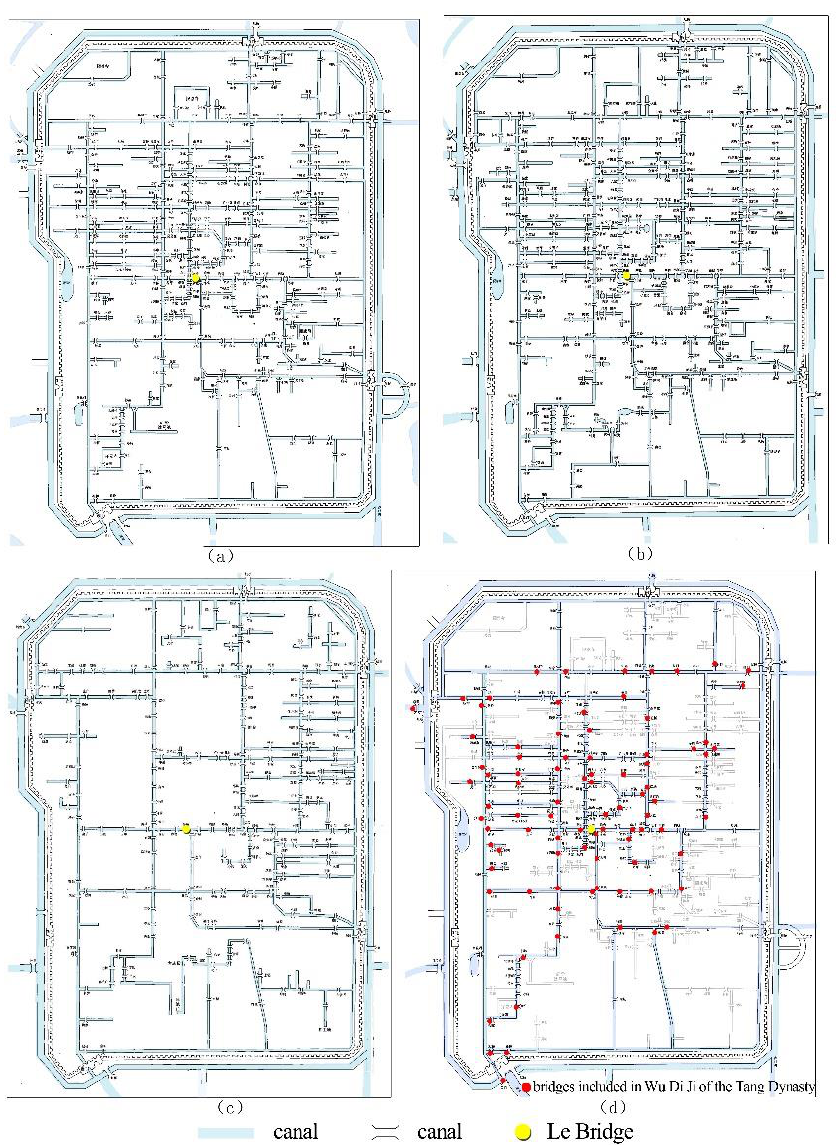
Figure 1. Canal maps of Suzhou in the Tang, Song, Ming and Qing Dynasties. ( a ) Canal map of the Song Dynasty. ( b ) Canal map of the Ming Dynasty. ( c ) Canal map of the Qing Dynasty. ( d ) Canal map of the Tang Dynasty.